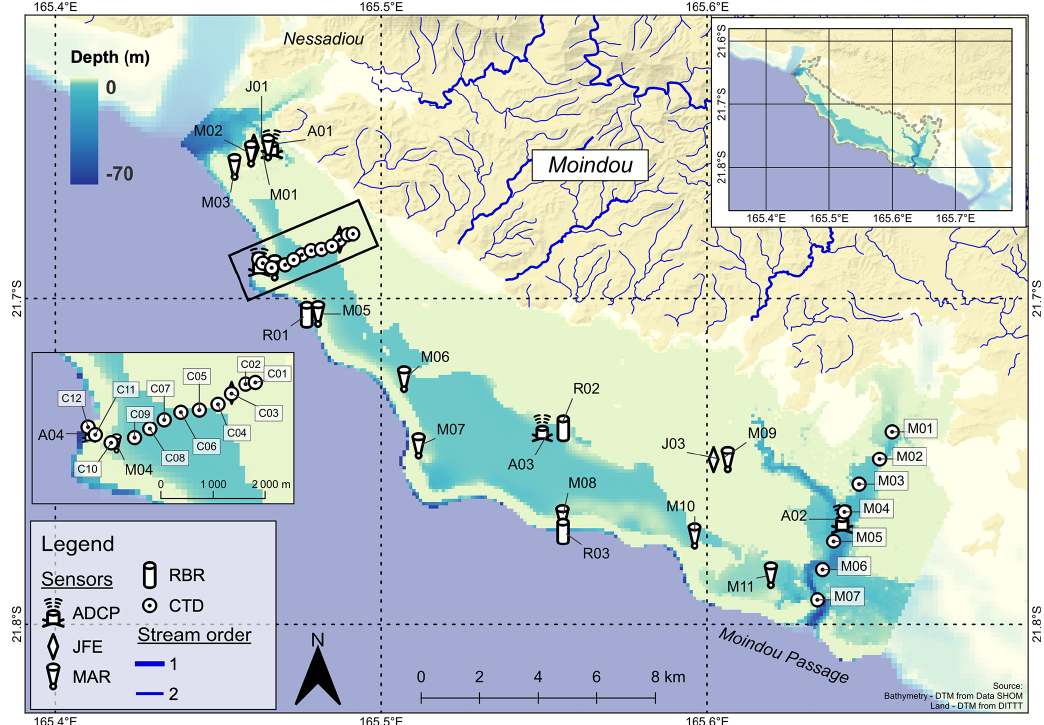
Figure 3. A depiction of the observational strategy deployed within the Moindou lagoon during NEMO campaign. ADCP: acoustic doppler current profiler; JFE: INFINITY-CTW; MAR: Marotte HS; RBR: RBRduo T.D or RBRduet T.D; CTD: conductivity – temperature –